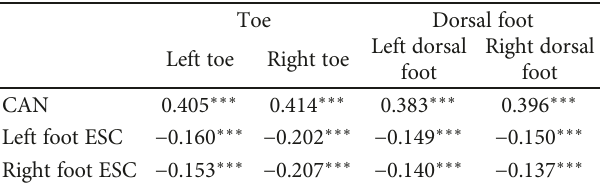
Table 2: Spearman ’ s correlation coe ffi cients between feet ESC values, CAN value, and indices of VPT (toes and dorsal feet).